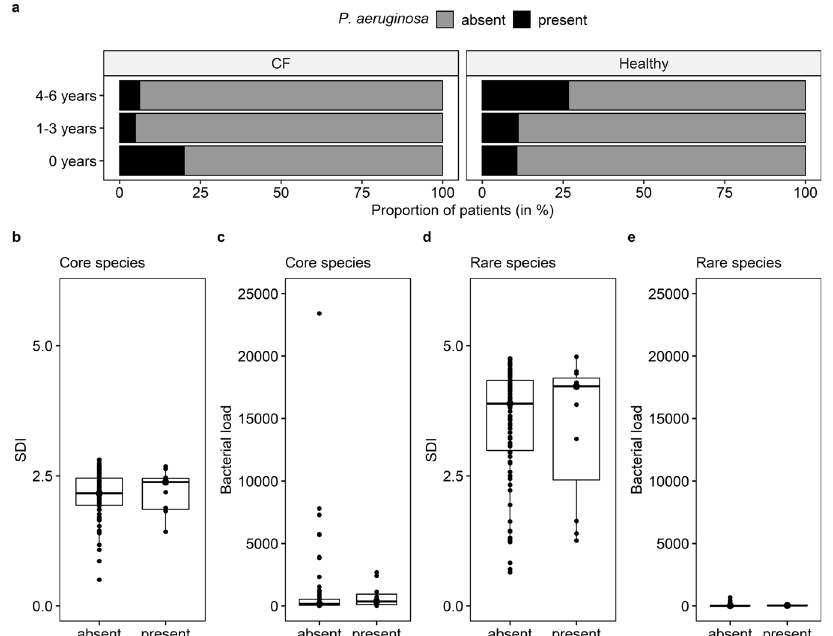
Fig. 6 Impact of P. aeruginosa -DNA detection on the respiratory tract metagenome of CF and healthy infants. a Proportion of P. aeruginosa -DNA-positive and P. aeruginosa -DNA-negative children per age group and disease state. In the CF cohort, there were 5 infants below the age of 1, 20 between 1 and 3 years of age and 16 children between 4 and 6 years of age. In the healthy cohort, there were 28 infants below the age of 1, 9 children between 1 and 3 years of age and 15 preschool children were 4 and 6 years of age. b – e Shannon diversity indices (SDI) ( b , d ) and bacterial load of core ( c ) and rare species ( e ) based on the presence (right) and absence (left) of P. aeruginosa -DNA in cough swabs. The Mann – Whitney U test was applied to calculate signi fi cant differences between the two groups. No statistical differences were observed ( p > 0.05). The centre line of the boxplot depicts the median (50th percentile). The lower and upper boundary of the box represent the fi rst (25th percentile) and third (75th percentile) quartile, and hence de fi ne the interquartile range (IQR). Whiskers extend from the box to the largest/smallest non-outlier data point (1.5 ×